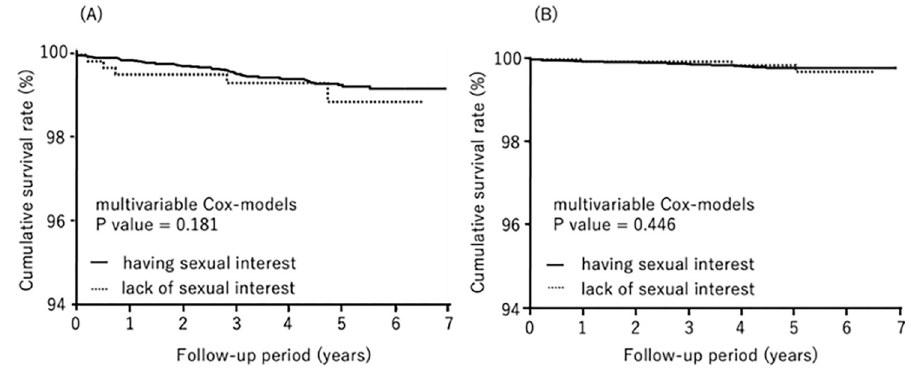
Fig 3. Kaplan-Meier analysis for cardiovascular disease survival by sexual interest. (A) males, (B) females.